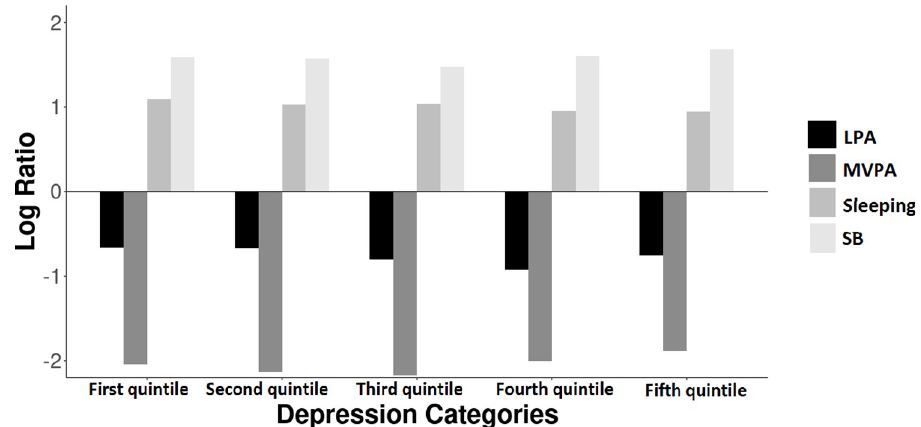
Fig 1. Compositional geometric mean bar plot for quintiles of depression/anxiety among adolescents. LPA, Light physical activity; MVPA, Moderate-to-vigorous physical activity; SB, Sedentary behavior.